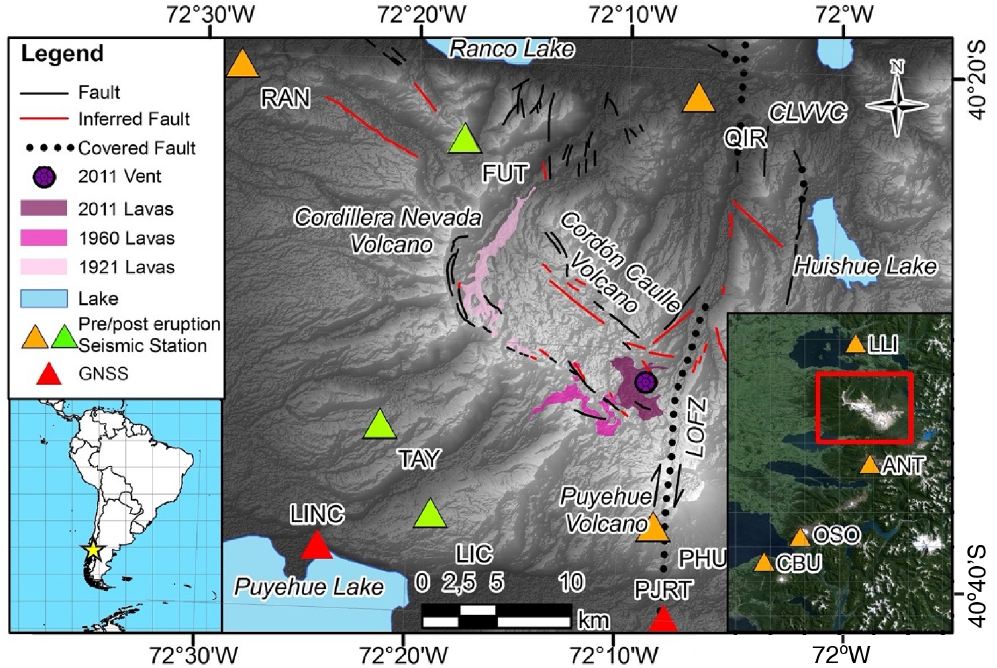
Figure 1. Location of Puyehue–Cordón Caulle Volcanic Complex (PCCVC) in the Southern Volcanic Zone (SVZ) of the Andes of southern Chile. On the topographic map, we mark the main geological structures, noting the Liquiñe–Ofqui Fault Zone (LOFZ; Lara et al., 2006); the graben between the Cordillera Nevada volcano and Puyehue volcano; lava flows generated by the 1921, 1960, and 2011 eruptions; the 2011 open vent, and the location of seismic stations (orange triangles for pre-eruption locations and green triangle for post-eruption locations). The inset in the bottom-right corner (map extracted from © Google Earth) shows the location of far-field seismic stations, with the red square marking the location of the study area. The red triangles at the bottom show two GNSS sites cited in Wendt et al. (2016). CLVVC is the Carran–Los Venados Volcanic